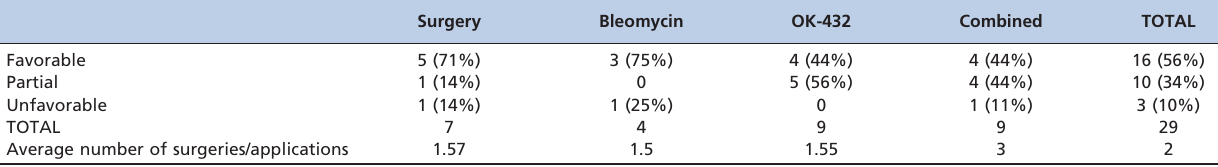
Table 4 - Final response to